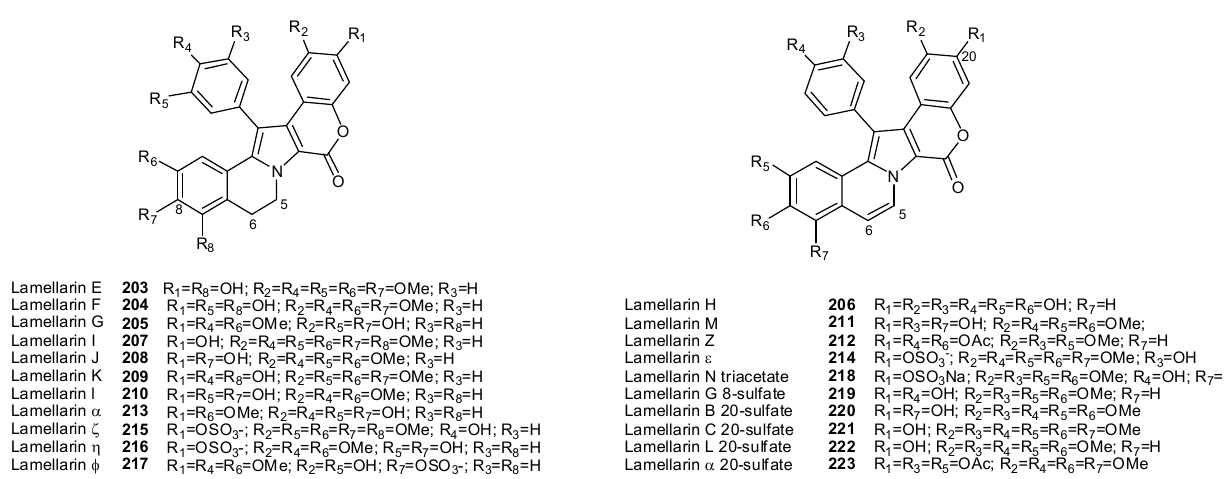
Figure 24. Structures of lamellarins isolated from